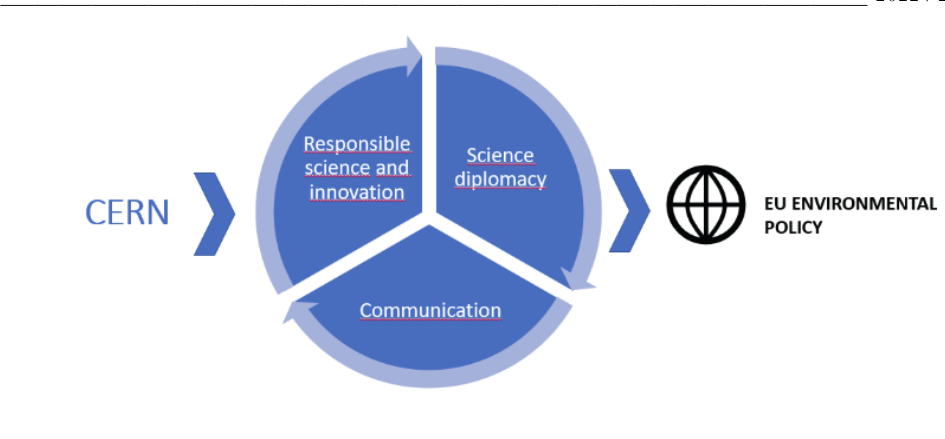
Fig. 1. Mechanism of science diplomacy and responsible science addressing global